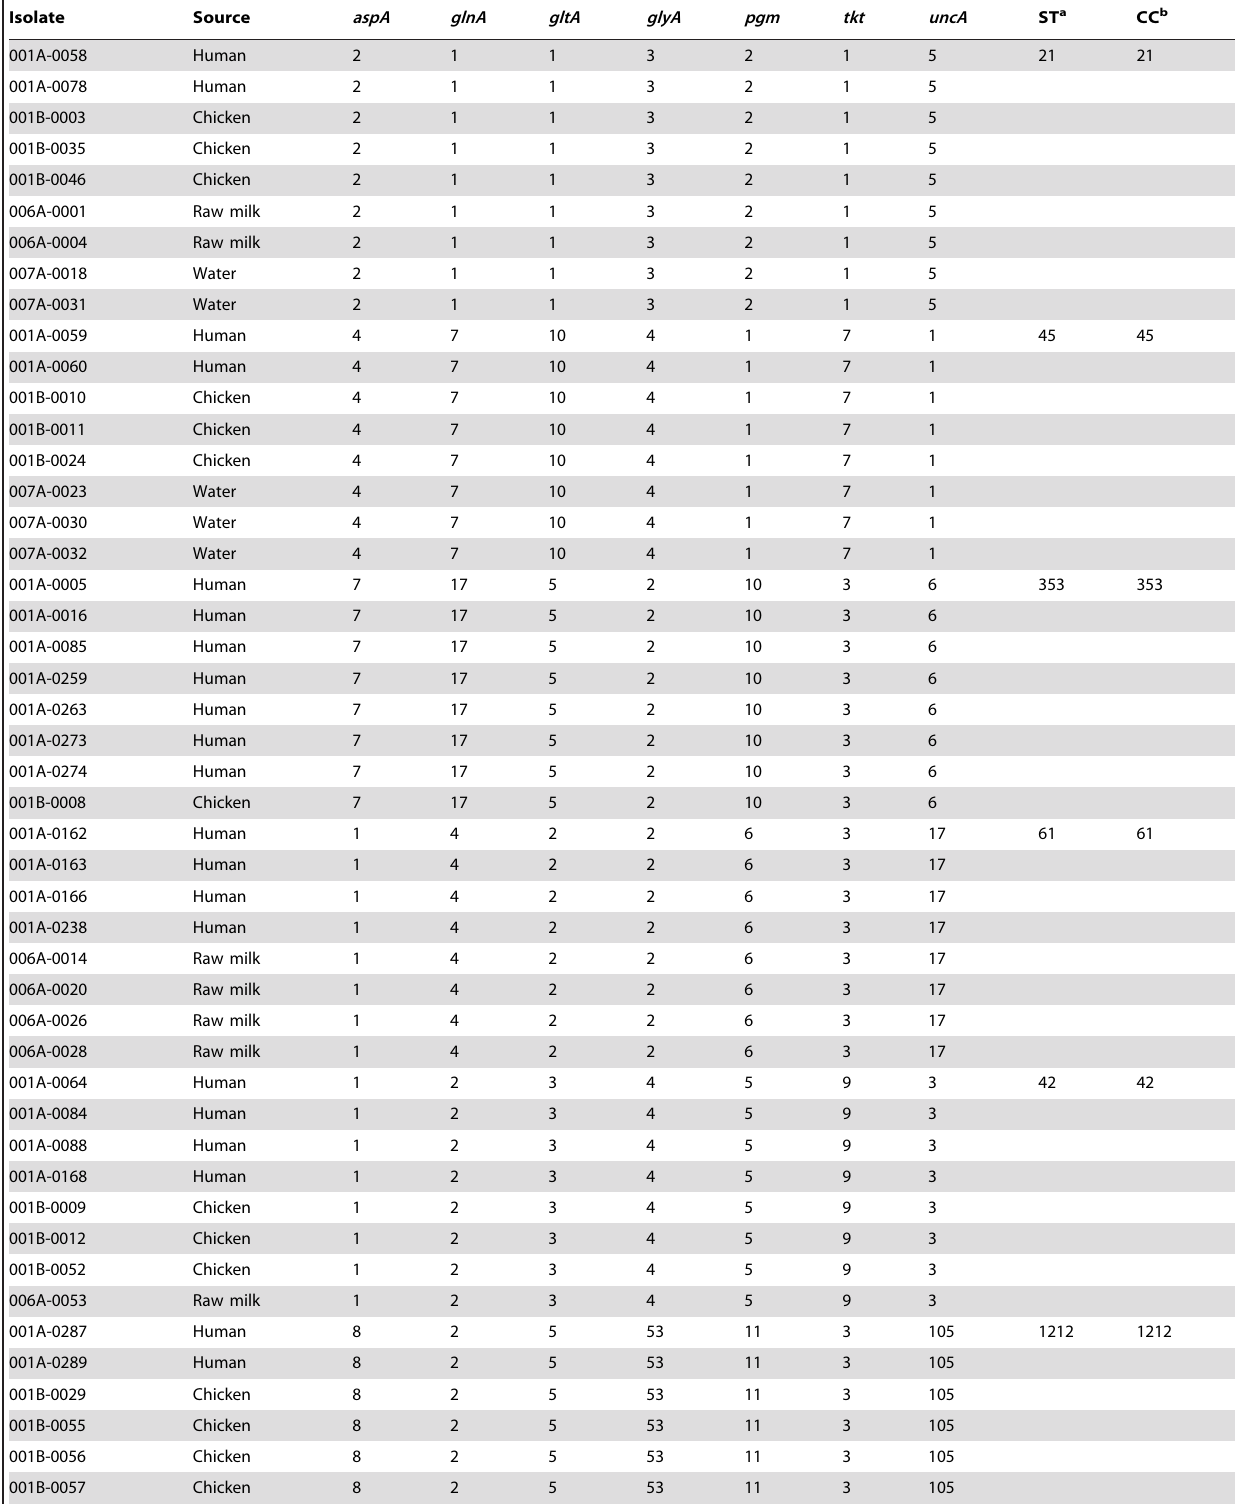
Table 8. C. jejuni isolates used in the study.